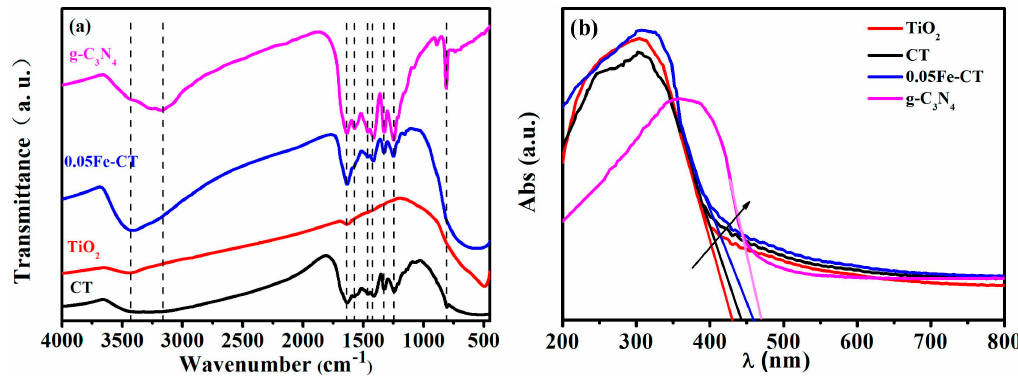
Figure 4. FTIR spectra ( a ) and UV ‐ vis DRS; ( b ) of g ‐ C 3 N 4 , TiO 2 , CT, and 0.05Fe ‐ CT.